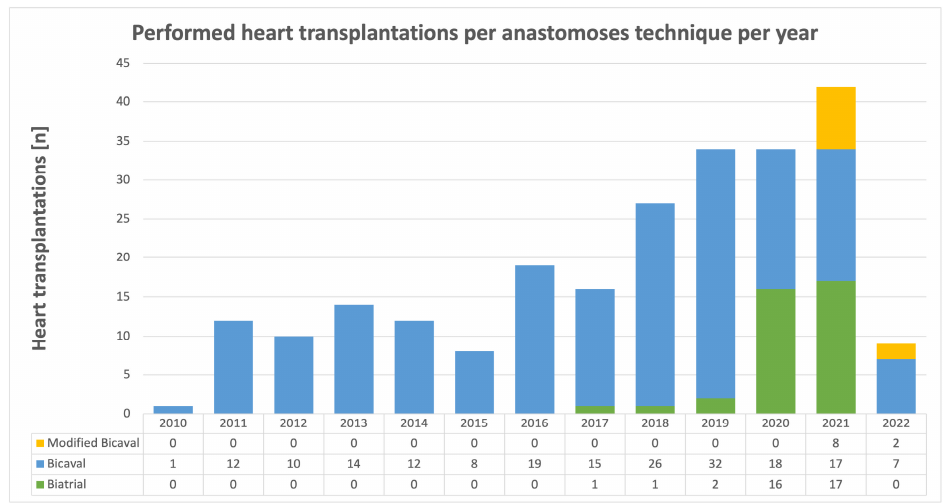
Figure 2. Performed heart transplantation per anastomoses technique and per year during the study period between September 2010 and March 2022. Between 2010 and 2016 only bicaval technique was performed. Modified biatrial technique was introduced in